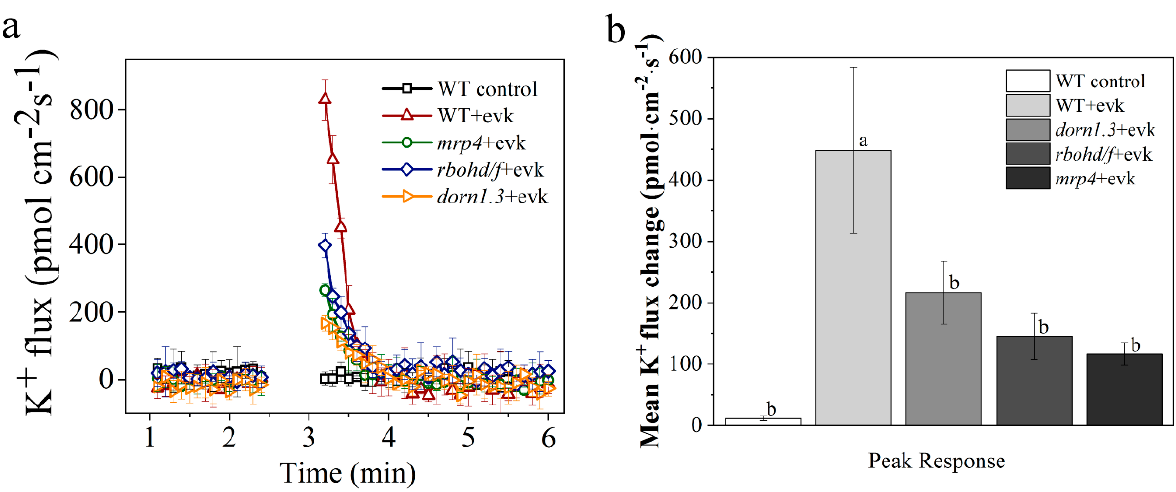
Figure 5. Evk-induced net K + flux in WT, mrp4 , dorn1.3 , and rbohf mutant guard cells. ( a ) Net K + flux in WT, mrp4 , dorn1.3 , and rbohd/f mutant guard cells. K + flux was measured in guard cells for 3–5 min. Then, 8 μ M evk was added to the test buffer. Each point was the mean of at least 3 individual guard cells and bars represent the standard error of the mean. ( b ) Mean K + fluxes in WT, mrp4 , dorn1.3, and rbohd/f mutant guard cells during the peak response periods. Error bars denote ± SEM, n ≥ 3, and means labeled with different letters are significantly different at p < 0.05, Dunnett’s C (variance not neat).